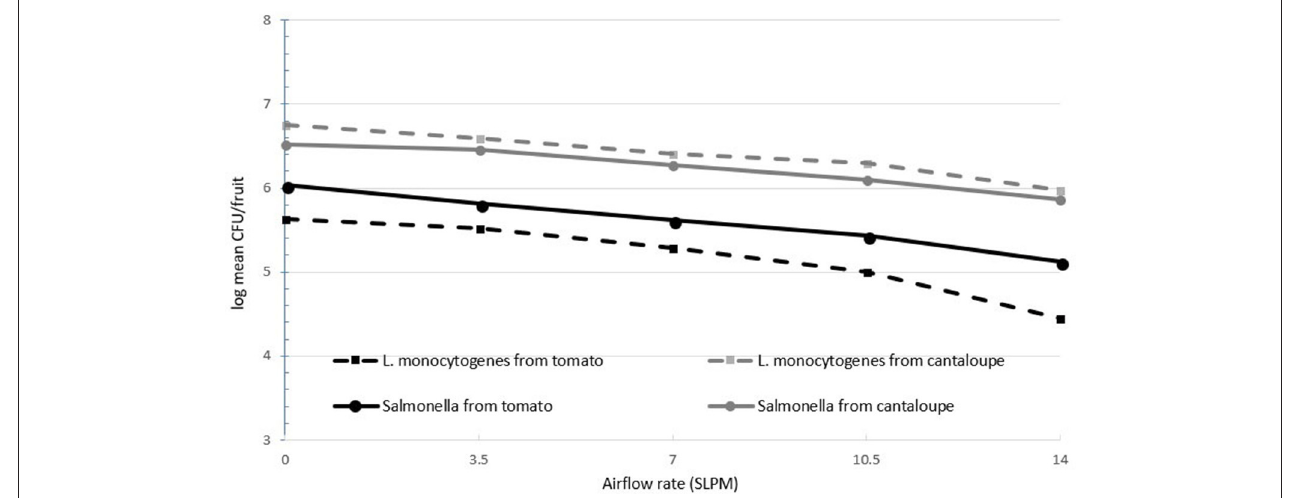
FIGURE 1 | Recovery of inoculated L. monocytogenes and Salmonella Newport from the surfaces of Roma tomatoes and cantaloupe ( n = 6).